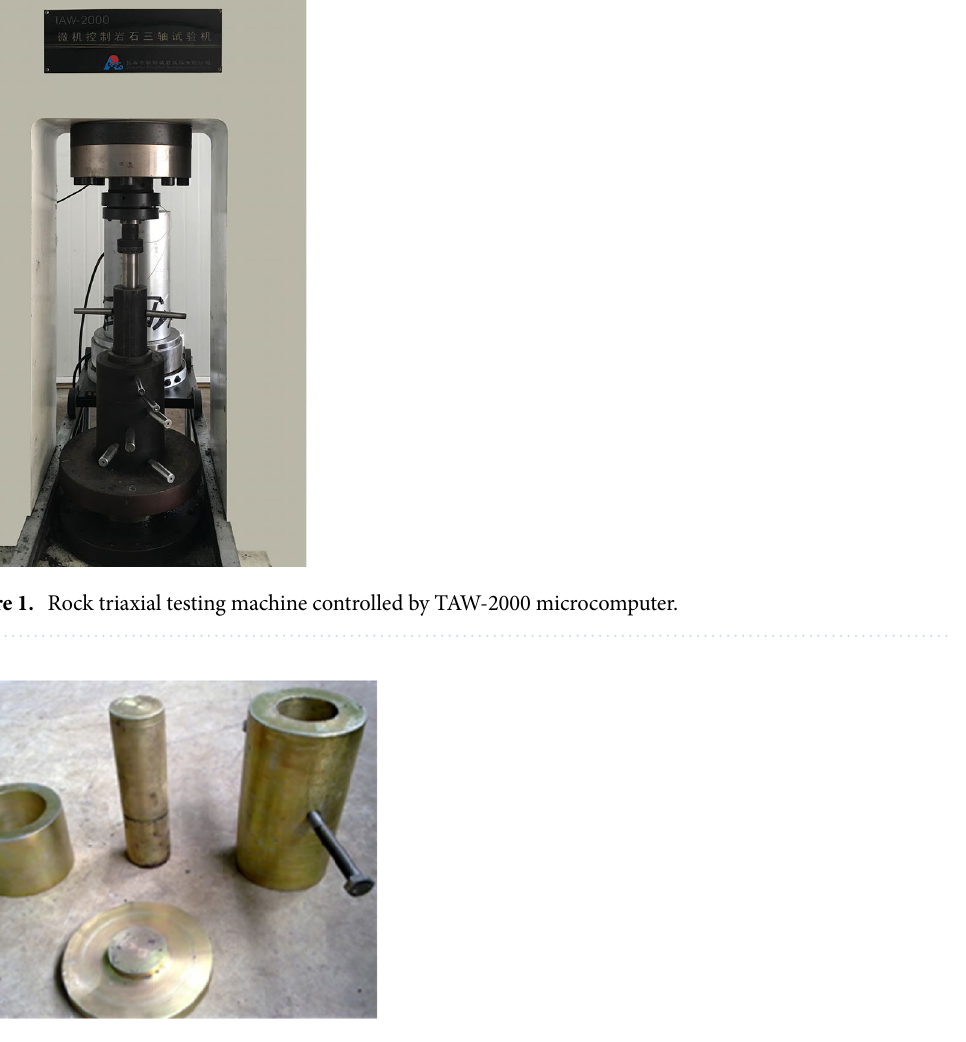
Figure 2. Φ 50mm × 100 mm pressing